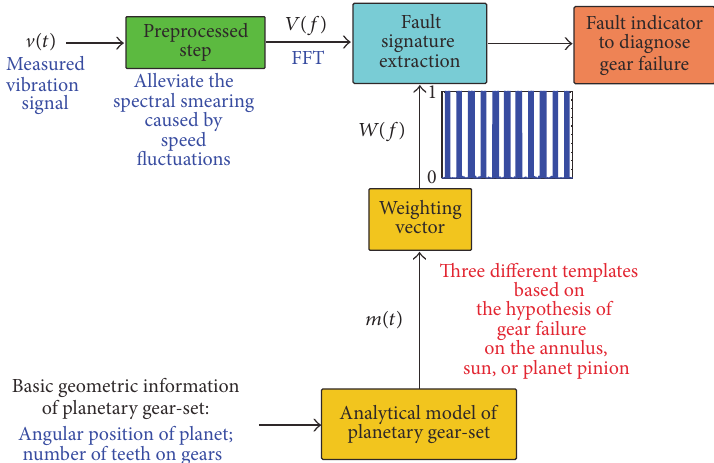
Figure 3: The architecture of the proposed vibration based diagnostic